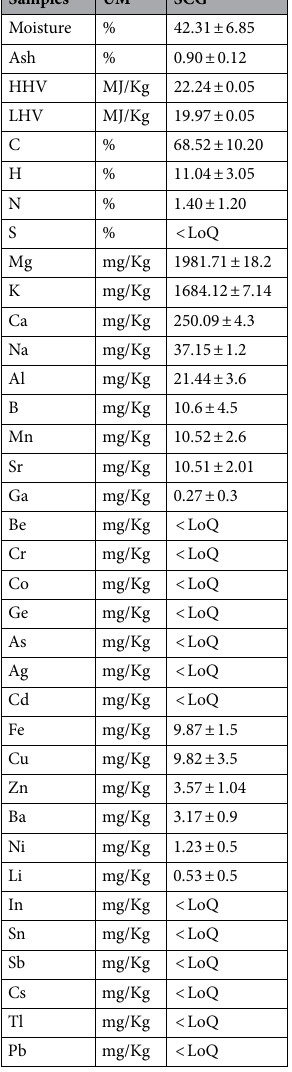
Table 5. Results of the SCG characterization and metals detected in SCG. Data are presented as mean ± standard